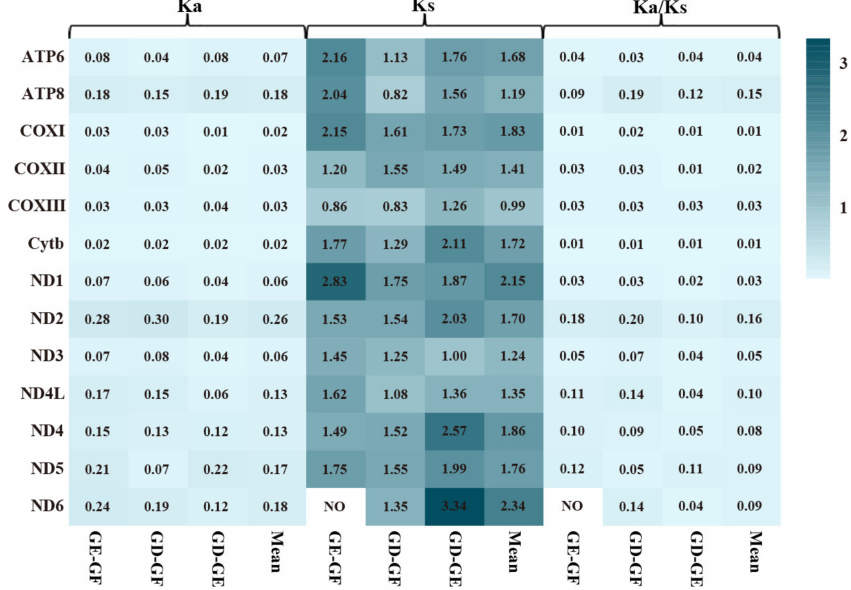
Figure 6. The rates of non-synonymous substitutions and synonymous substitutions for each PCG in pairwise mitochondrial genome of G. filamentosus (GF), G. erythrourus (GE), and G. decacanthus